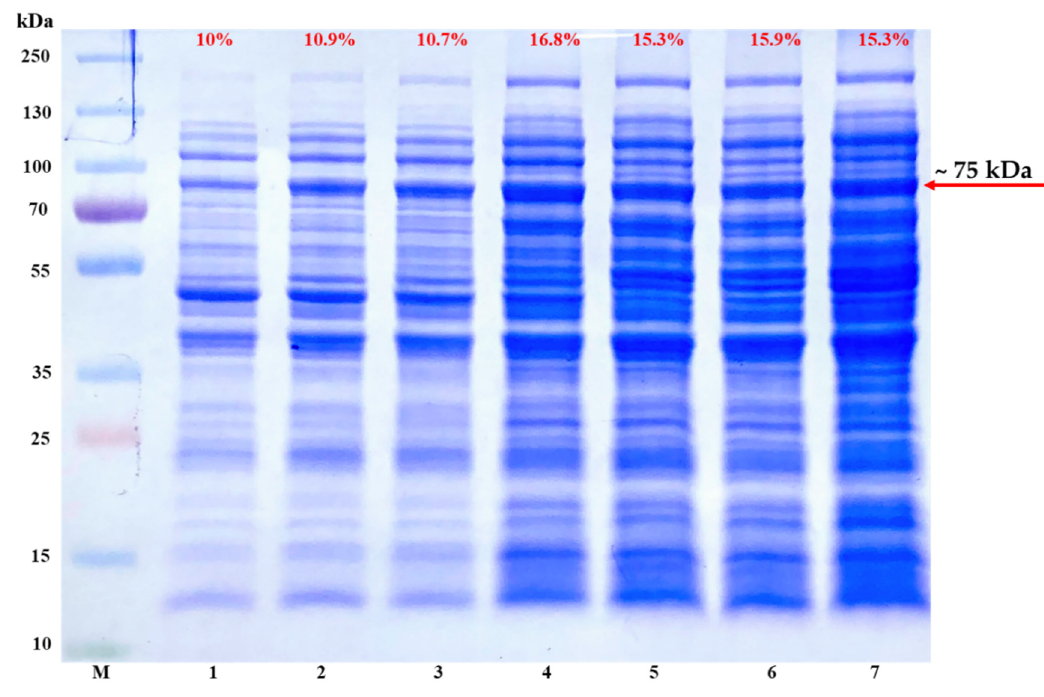
Figure 3. The effect of L-rhamnose concentration on recombinant protein expression in Lemo21(DE3) competent cells transformed with pET-30a(+)-TP-coreSA vector. The SDS-PAGE is imaged as ( M ) protein ladder, ( 1 ) control (without L-rhamnose), ( 2 – 7 ) starting from lane 2 with 100 µM concentration of L-rhamnose followed by 250, 500, 750, 1000, and 2000 µM, respectively. The percentages of TP-coreSA in crude protein for all lanes were calculated and added into the gel images showing on top of each lane (in red).